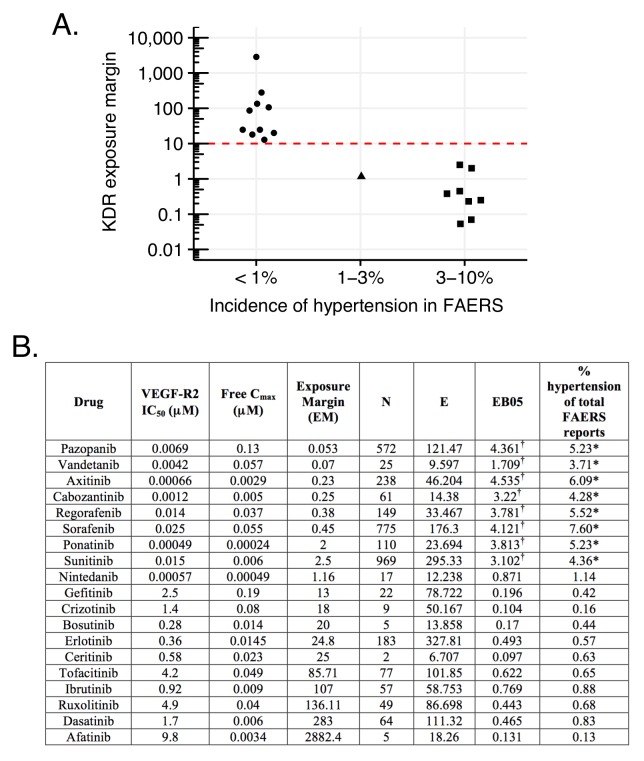
Hypertension associated with VEGF-R2 inhibition depends on the exposure margin of small molecule anti-VEGF-R2 drugs (VEGF-R2 IC50/Cmax).(A) Suggested exposure margin for marketed VEGF-R inhibitors based on post-marketing incidence of hypertension in correlation with plasma exposure (VEGF-R IC50/free Cmax). The proposed 10 times margin represents clear separation of VEGF-R inhibitors with and without significant increase in hypertension with the only exception of nintedanib. (B) FAERS reports of small molecule kinase inhibitors with VEGF-R2 inhibition show an increased incidence of hypertension reports only in case their exposure margin is less than 13. The label of drugs with high incidence of hypertension in FAERS lists this side effect, while none of those drugs that have low incidence carry the label. *p-value of association between drug and hypertension <0.001. Counts (N), expected counts (E), and an often-used disproportionality measure (EB05) based on the FDA’s FAERS database of spontaneous reports of suspected drug adverse drug reactions are provided. The values of E are the expected number of patients reporting vascular hypertensive disorder after taking each drug if the drug reports and the reports of the event were independent within the database, conditional on the patients age and gender. The ratio N/E is a measure of disproportionality of report counts of each particular drug-event combination. The value EB05 (empirical Bayes 5% lower bound of a 90% credible interval) is a conservative estimate of the true reporting disproportionality that uses estimated overall prevalence of drug-ADR associations throughout the database. The value of EB05 is less than N/E and has the effect of correcting the simple ratio for sampling variance and multiple comparisons bias. See literature (DuMouchel, 1999; DuMouchel and Pregibon, 2001; Szarfman et al., 2002; Almenoff et al., 2007) for details and discussion of the FAERS database and the use of disproportionality analyses within spontaneous report databases. The values of EB05 for the first three drugs indicate 95% confidence that reports of those three drug-event combinations are reported about three or four times as often as would be expected if they were independent, while the values of EB05 <1 in the final three drugs in the table indicate no evidence for higher than expected reporting rates. More detailed results from Bayesian analysis are available in Supplementary file 3. †Significant increase.